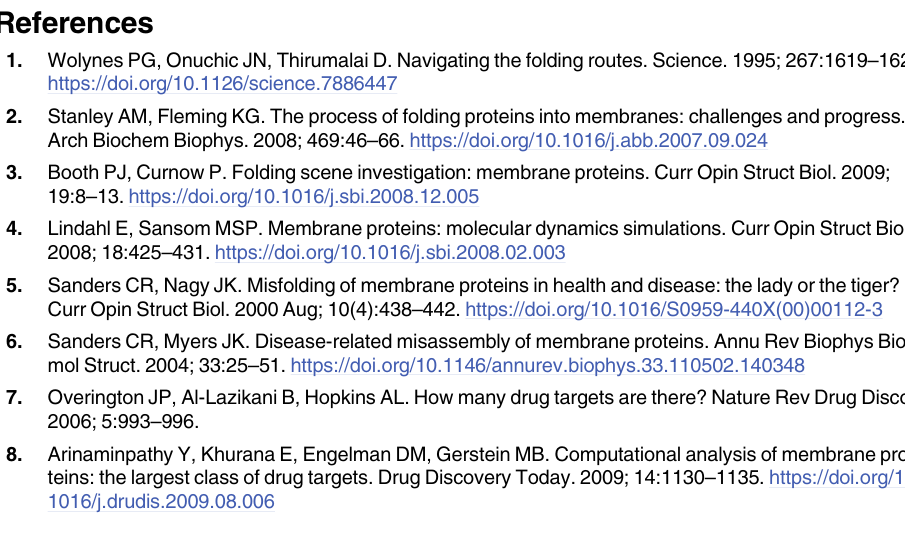
S1 Table. Summary of details of shooting attempts in transition-path sampling simula-